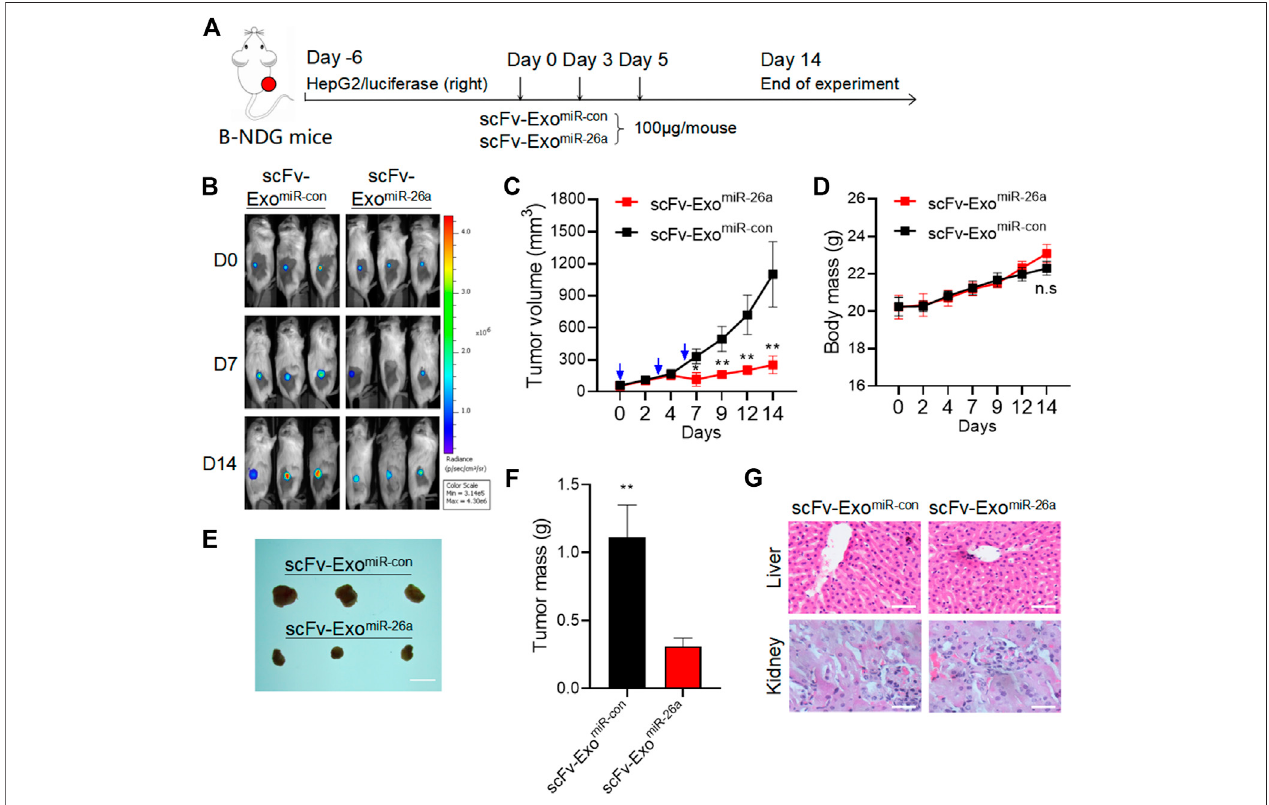
FIGURE 5 | Exosomes-based nanosystem displayed favorable anti-tumor effect in vivo with no obvious side effects. (A) Schematic representation of the experimentalarrangementforanimalexperiments. (B) Invivo liveimagingofmousewithHCCtumorformedbyHepG2/luciferasecells. (C) Tumorvolumewasmeasured over time.* p < 0.05, ** p < 0.01. (D) Thesemice werefed for14 days for weight analysis. (E) Tumorscollectedfrom mice were exhibited. Scale bars (cid:2) 1 cm. (F) Average tumour weight in each group was calculated. ** p < 0.01. (G) Mice were sacri fi ced after in vivo imaging, and HE staining of liver and kidney tissues was then performed. Scale bars (cid:2) 50 μ